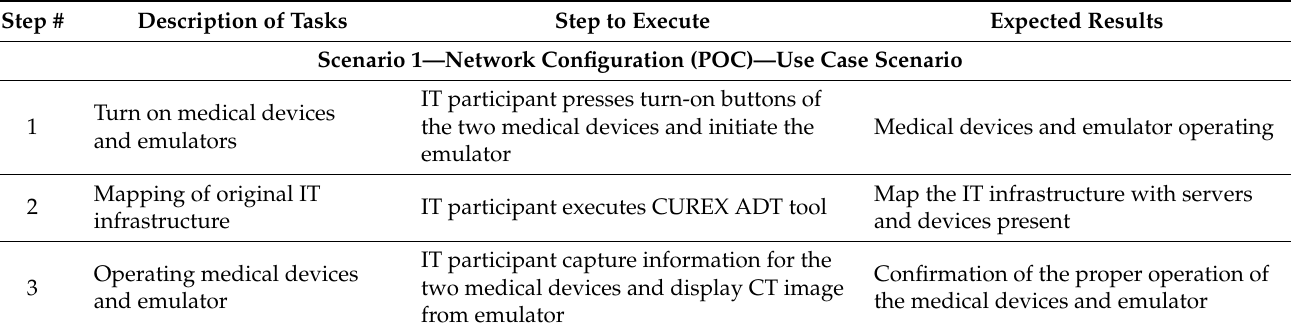
Table 5. Use case scenarios validation steps-by-step plan